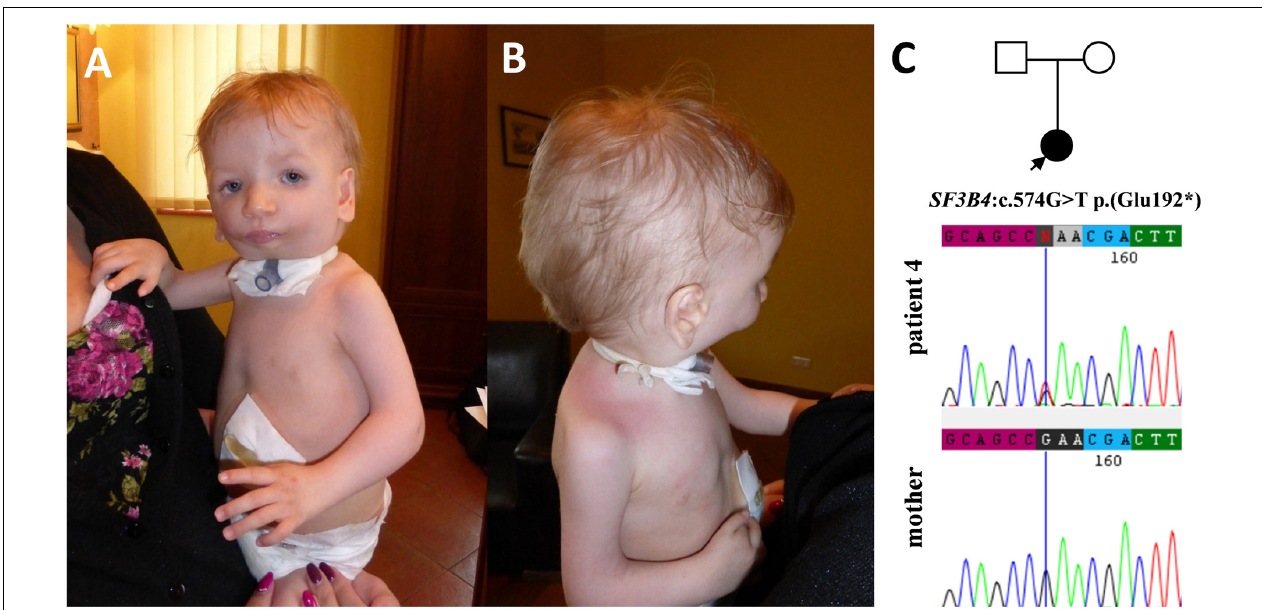
FIGURE 4 | Clinical characteristics of patient 4 affected by Nager syndrome (A,B) . Patient 4 carries a heterozygous variant c.574G > T p.(Glu192*) within the SF3B4 gene, which was excluded in her healthy mother (C) .